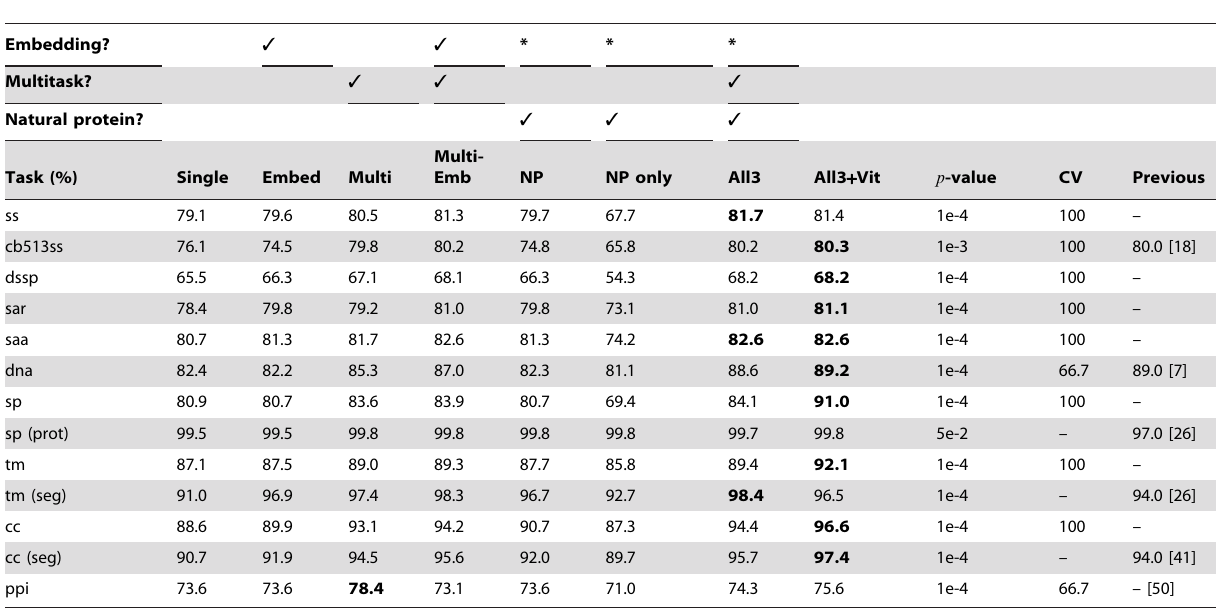
The table lists, for each prediction task, the per-residue percent accuracy achieved via single-task training of the neural network with just the PSI-BLAST features (‘‘Single’’), single-task training that includes the amino acid embedding (‘‘Embed’’), multitask training just using the PSI-BLAST features (‘‘Multi’’), multitask training including the amino acid embedding (‘‘Multi-Emb’’), multitask training of one task along with the natural protein task (‘‘NP’’), multitask training without the PSI-BLAST embedding module but initializing the amino acid embedding by using the natural protein task (‘‘NP only’’), multitask training including the natural protein task (‘‘All3’’), ‘‘All3’’ with Viterbi post-processing (‘‘All3 + Vit’’) and a previously reported method (‘‘Previous’’). Each row corresponds to a single task. The p -value column indicates whether the difference between ‘‘Single’’ and ‘‘All3 + Vit’’ is significant, according to a Z-test. The ‘‘CV’’ column is computed based on the accuracies separately for each cross-validation fold. It counts the percentage of CV folds in which the ‘‘All3 + Vit’’ method outperforms the ‘‘Single’’ method. Rows labeled ‘‘(prot)’’ or ‘‘(seg)’’ report the protein- or segment-level accuracy, rather than residue-level accuracy. For the ‘‘NP’’ setting, the ‘‘*’’ in the ‘‘Embedding?’’ row indicates that this network uses the pre- trained embedding layer from the natural protein task. doi:10.1371/journal.pone.0032235.t002 PLoS ONE |